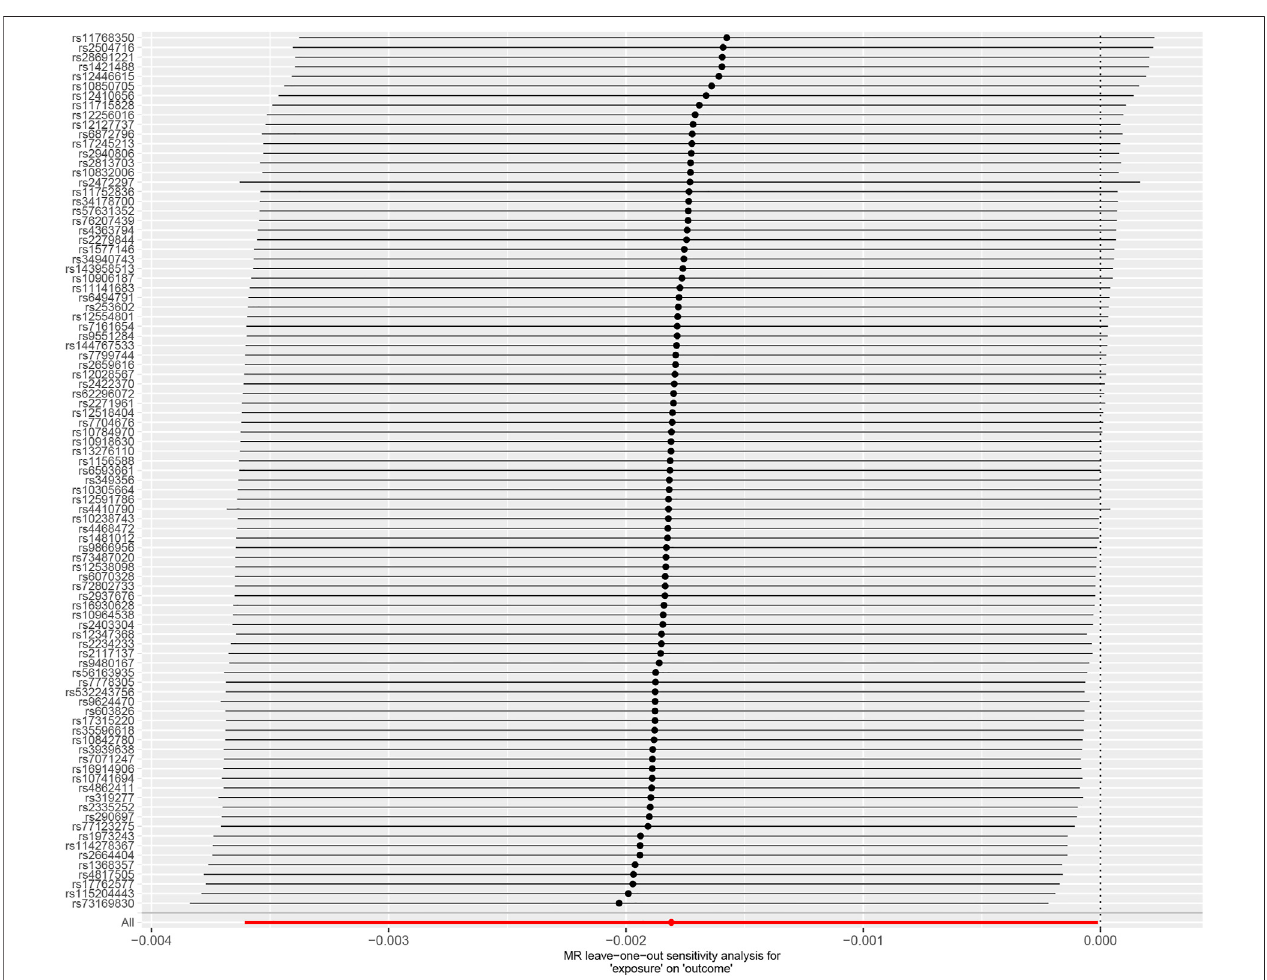
FIGURE 3 | Forest plot of “ leave-one-out ” sensitivity analysis method to show the in fl uence of individual SNP on the results. MR, Mendelian randomization.